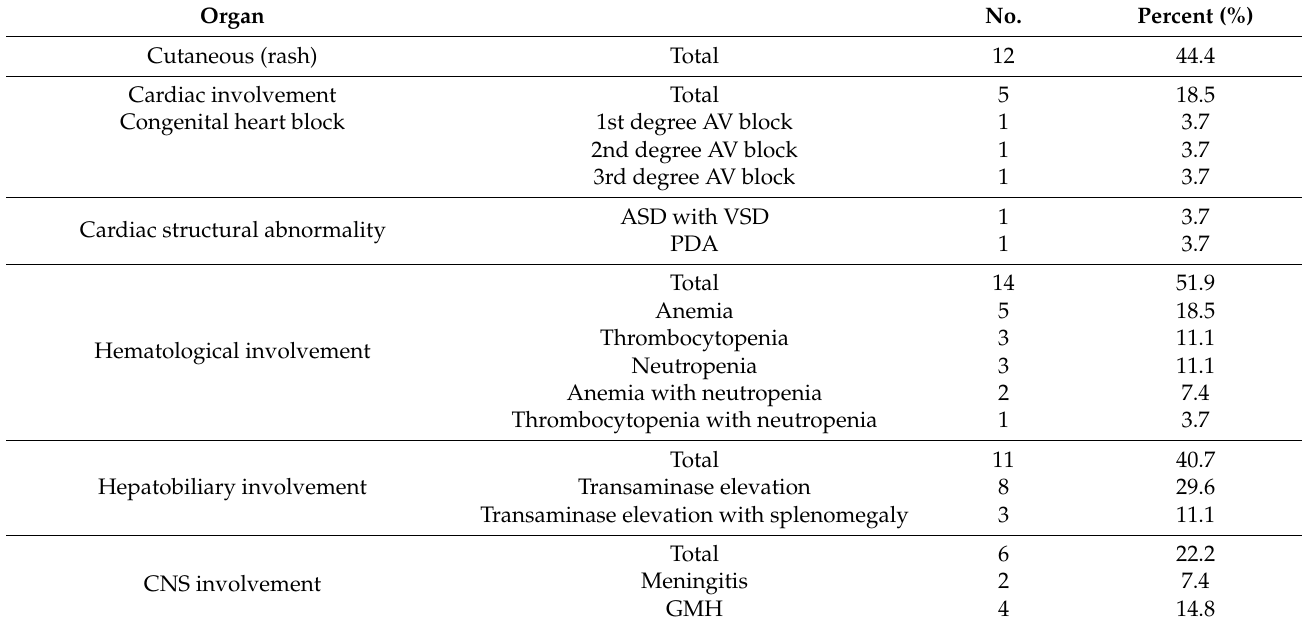
Table 3. Organ involvement of patients with NLE ( n =